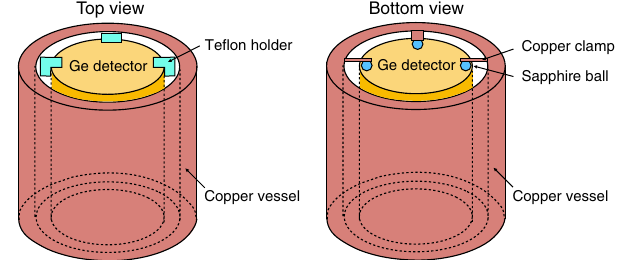
FIG. 20. Schematic depiction of the EDELWEISS Ge detector module used to take the data described in Ref. [70]. The Teflon ¼ 2 . 2 g = cm 3 ). The holders each have a mass of 0.05 g ( ρ PTFE sapphire balls have a diameter of 3.18 mm, and each has a mass of ¼ 3 . 98 g = cm 3 0.067 g ( ρ Al 2 O 3